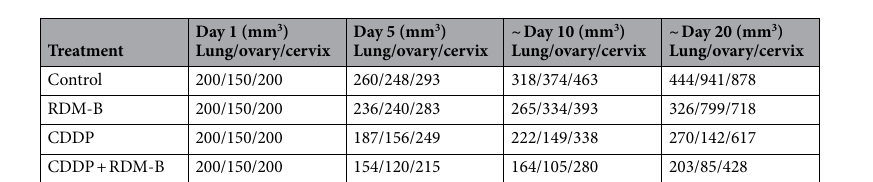
Table 1. Measured volumes of tumours of lung (A549)/ovary (NIH:OVCAR-3)/cervix (ME-180) at day 1, 5, 10, and 20 of the treatments by the vehicle (control), 8 mg/kg RDM-B (BV10) only, 2.0/2.5 mg/kg CDDP only, and 2.0/2.5 mg/kg CDDP + 8 mg/kg RDM-B (BV10). All tumour volumes were normalized to the Day 1 value (200 mm 3 for the lung and cervix models, 150 mm 3 for the ovary